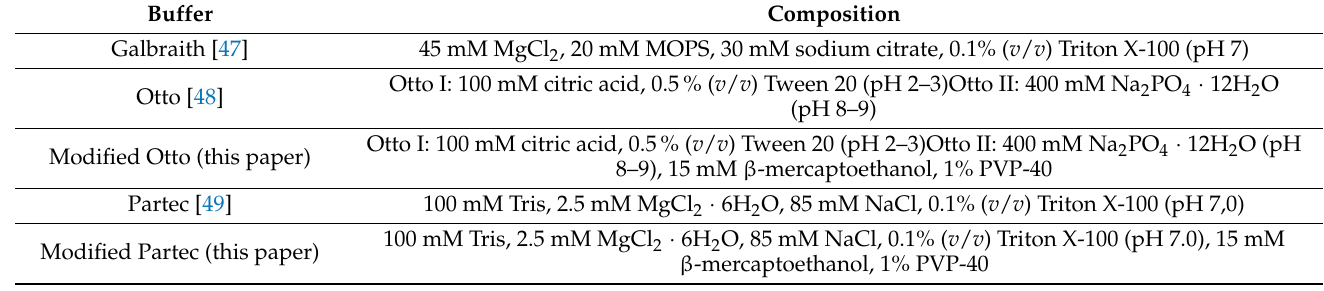
Table 2. Nuclei isolation buffers and their compositions.